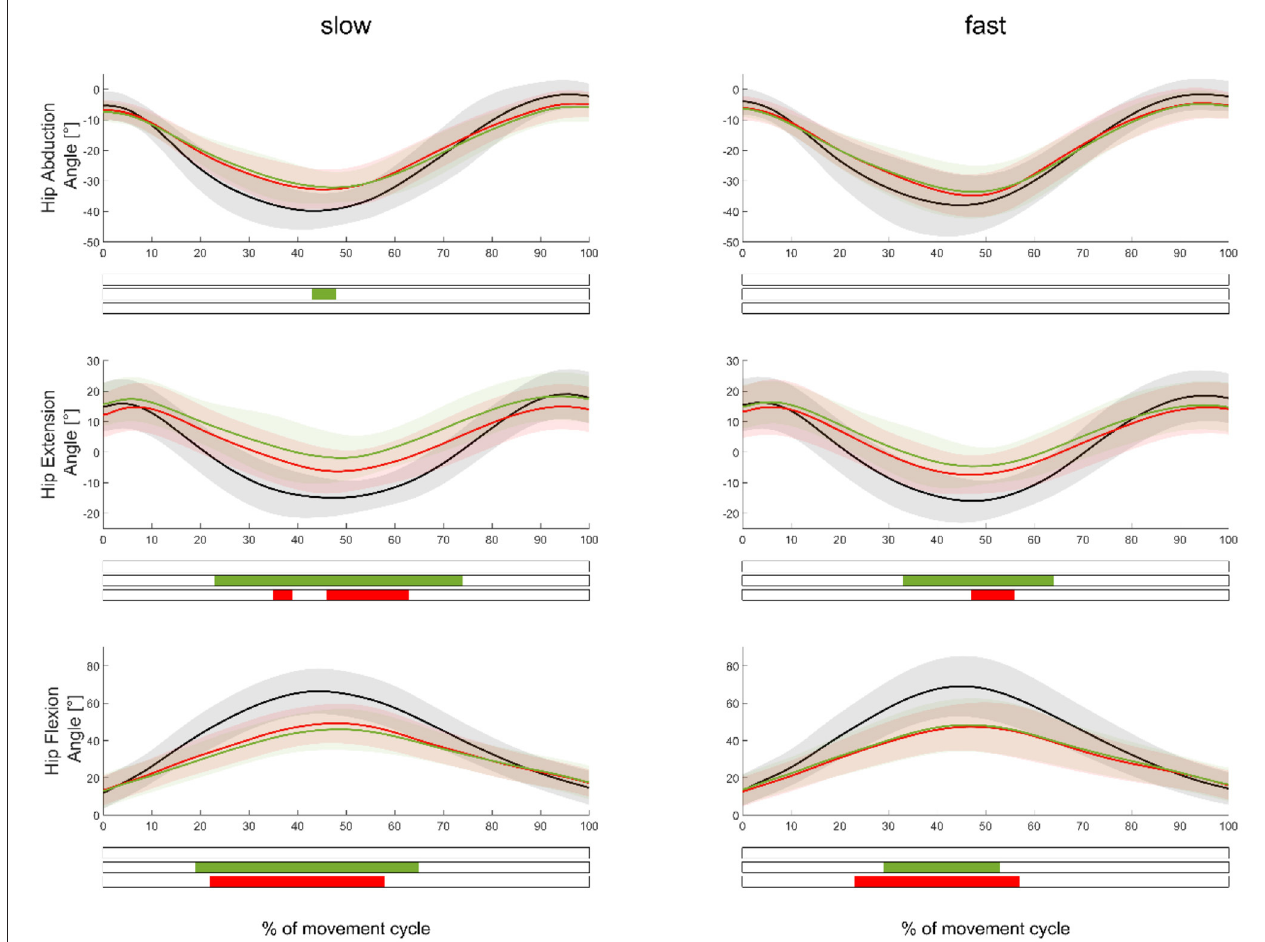
FIGURE 5 | Mean ( ± SD) hip angle waveforms measured in the movement leg during hip abduction (top), extension (middle), and flexion (bottom) exercises, as well as during slow (left subplots) and fast (right subplots) velocities. Green, red, and black waveforms represent the stiffer, softer, and no ERBs, respectively. Colored bars beneath each plot indicate significant differences between waveforms, whereas the green, red, and blue (first) bars represent significant differences between the stiffer vs. no ERB, softer vs. no ERB, and stiffer vs. softer ERB,